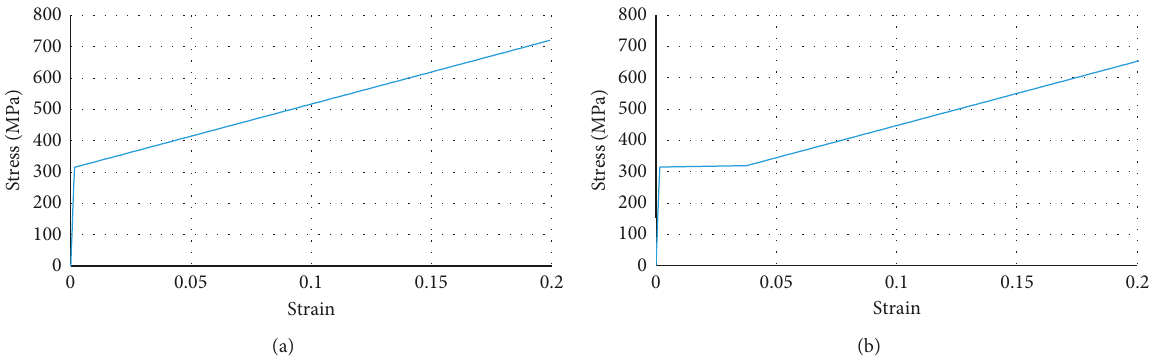
Figure 24: Stress-strain relationship for (a) SM490 and (b) SMA400w grade steels.